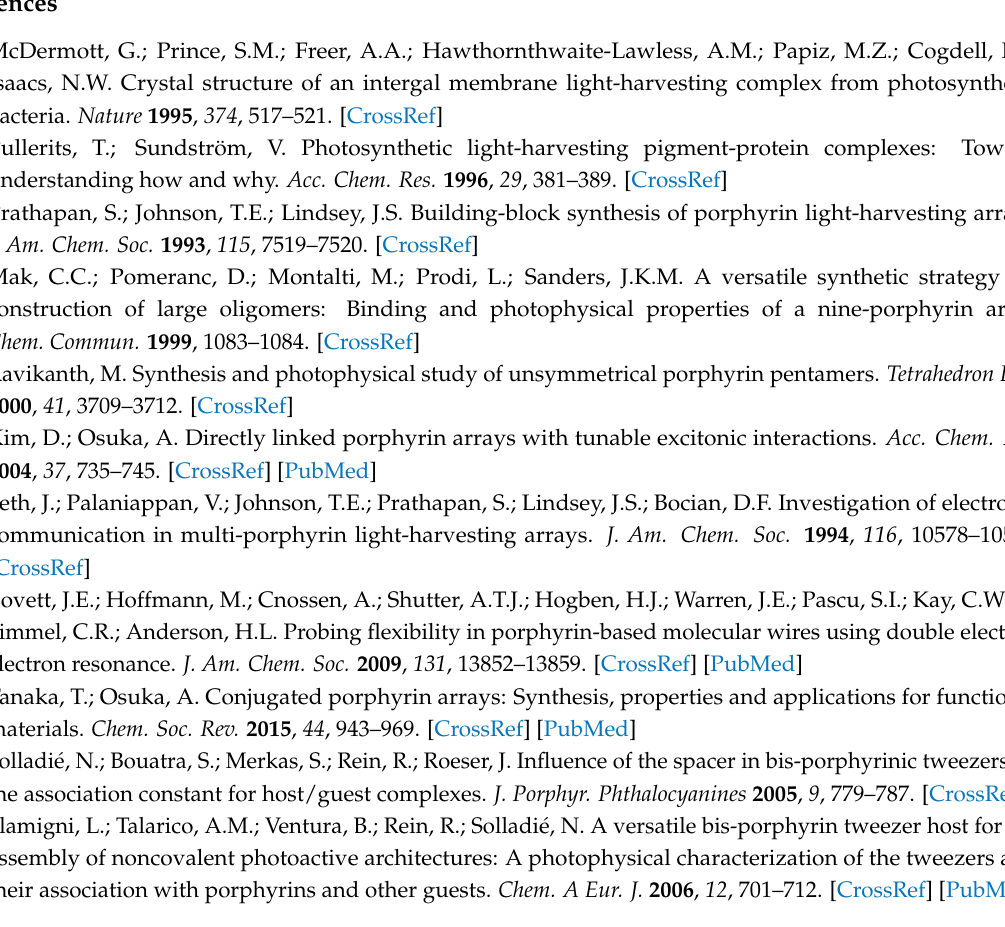
Supplementary Materials: The following are available online, Figure S1: LC-MS chromatograms of compound 1 – 3 with UV detection at 220 nm, Figure S2: Temperature dependent CD spectra ( a ) and UV-vis spectra ( b ) of 2 (0.27 µ M) in CH 2 Cl 2 , Figure S3: CD and UV-vis spectroscopic titration of 2 with dinitrogen guests, Figure S4: A representative non-linear fitting for the host-guest titration of 2 with 4,4 (cid:48) -dipyridyl, Figure S5: The CD and UV-vis spectral change of 3 (0.27 µ M in CH 2 Cl 2 ) with 4,4 (cid:48) -dipyridyl and 1,4-butanediol, Table S1: MS data of metalloporphyrin-peptoid